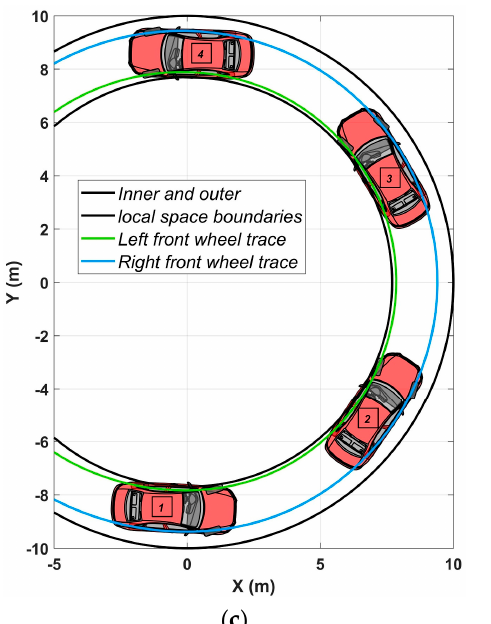
Figure 4. Simulation results for perpendicular forward parking and circular motion of a passenger car: ( a ) Position and trajectory (perpendicular forward); ( b ) Basic parameters (perpendicular forward); ( c ) Car positions and planned trajectories (circular); ( d ) Car's output and control parameters (circular).